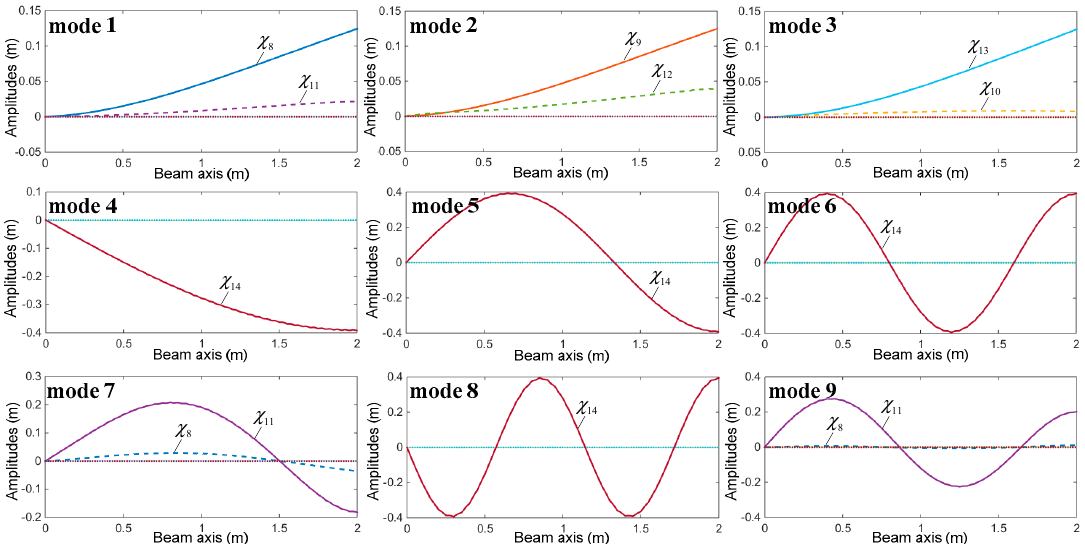
Figure 12. Longitudinal variations of the in-plane generalized displacements of the thin-walled members, in free vibration analysis.